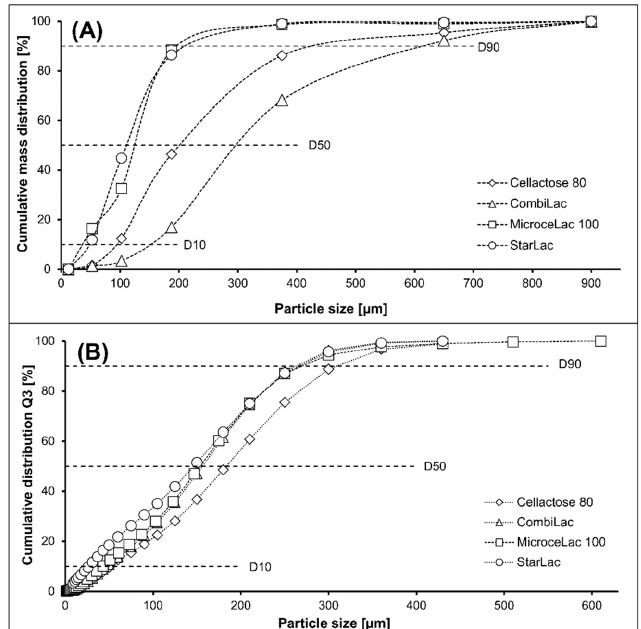
Figure 1. ( A ) Cumulative mass distribution by sieve; ( B ) particle size distribution by diffraction analysis.